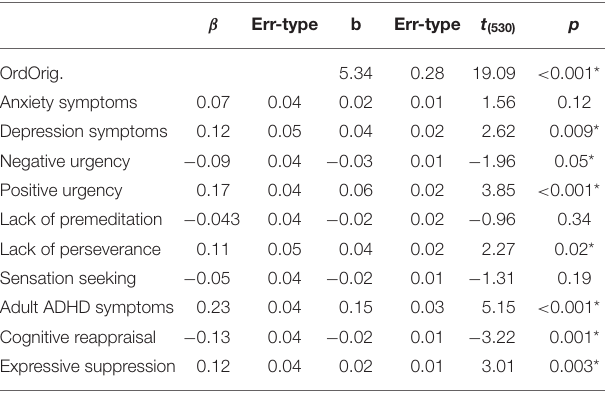
TABLE 2 | Multiple regression model explaining IAT scores.